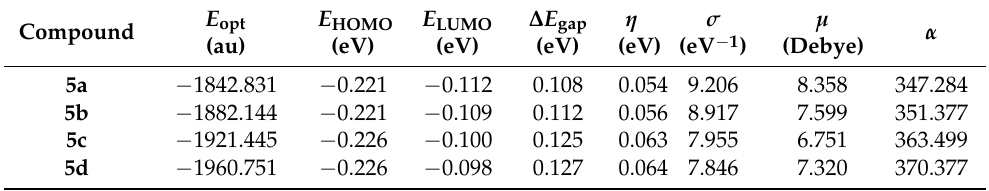
Table 3. Energies of the optimized compounds ( E opt , in au), the highest occupied molecular orbital ( E HOMO , in eV), and the lowest unoccupied molecular orbital ( E LUMO , in eV), along with energy gap ( E gap , in eV). Computed values of global hardness ( η ), global softness ( σ ), polarizability ( α ), and dipole moment ( µ ) of the studied